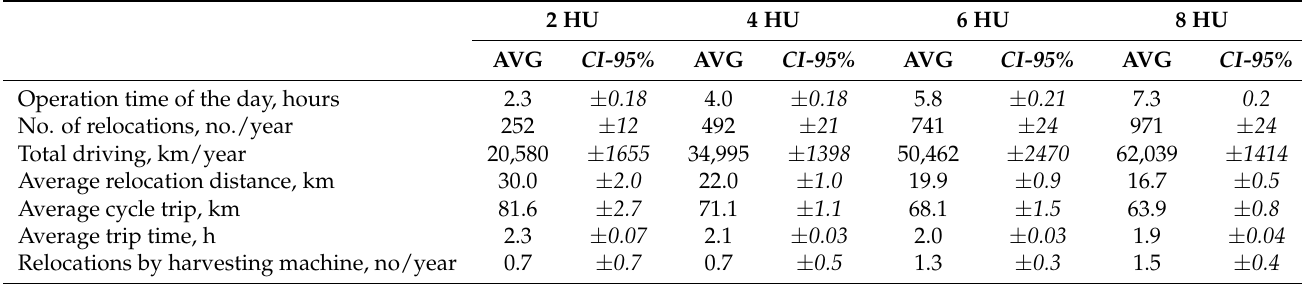
Table 10. Performance values of the relocation truck among simulation scenarios of 2, 4, 6, and 8 HU. Presented are 95% confidence intervals of 7